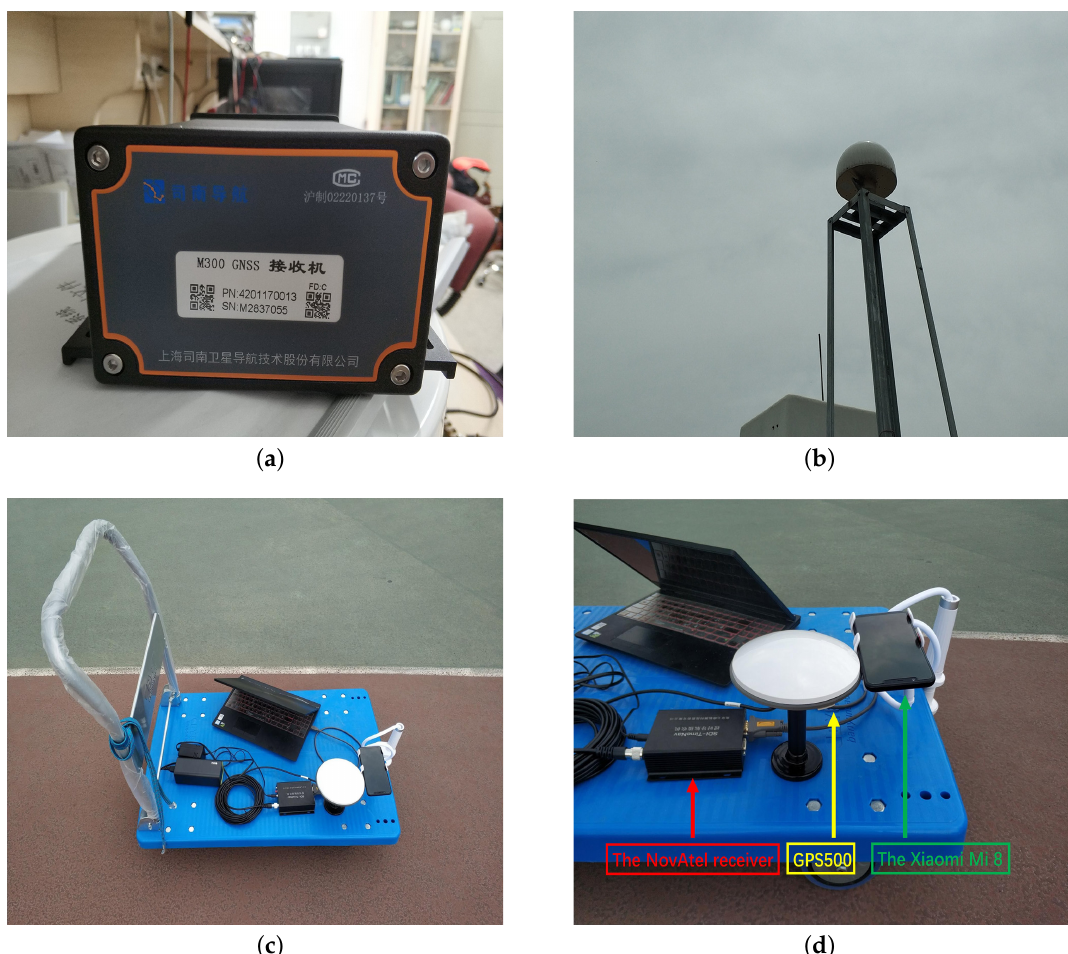
Figure 5. View of the base station and the rover. ( a ) View of the M300 receiver; ( b ) view of the antenna on the roof; ( c ) view of the rover; ( d ) brief description of the